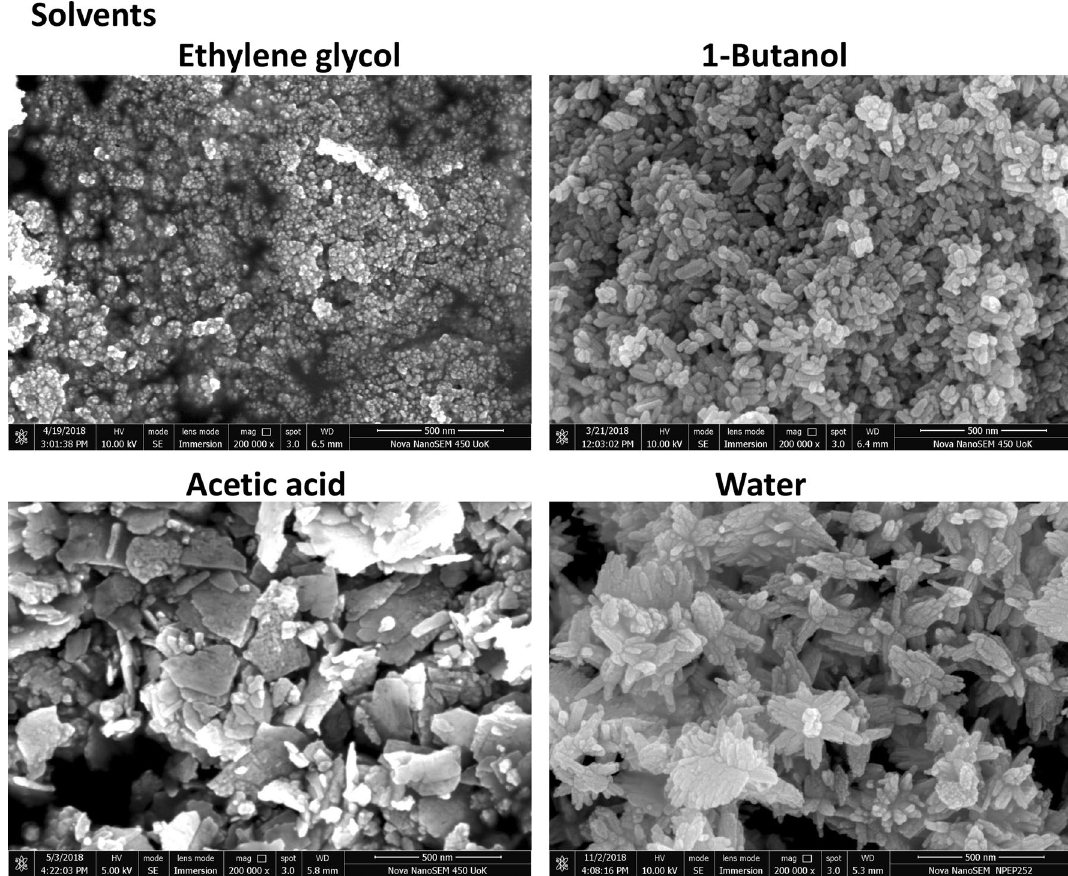
Figure 4. FESEM image of synthesized ZnO nanostructures in distinct solvents after aging for 24